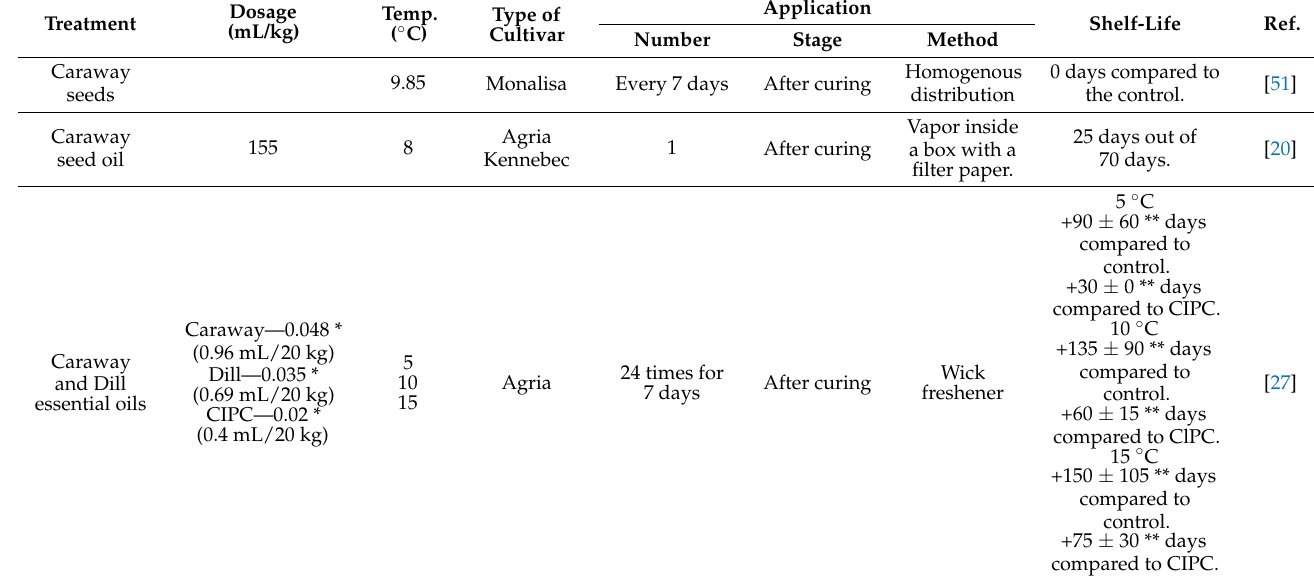
Table 5. Shelf-life studies on the efficacy of caraway seed essential oil as an alternative sprout suppressant.